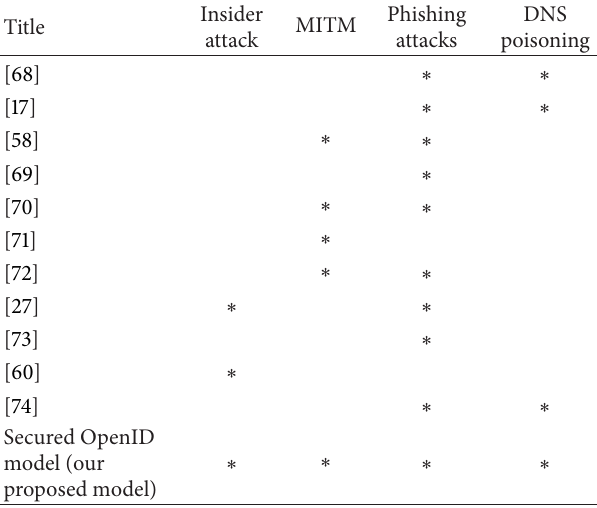
Table 1: Comparative